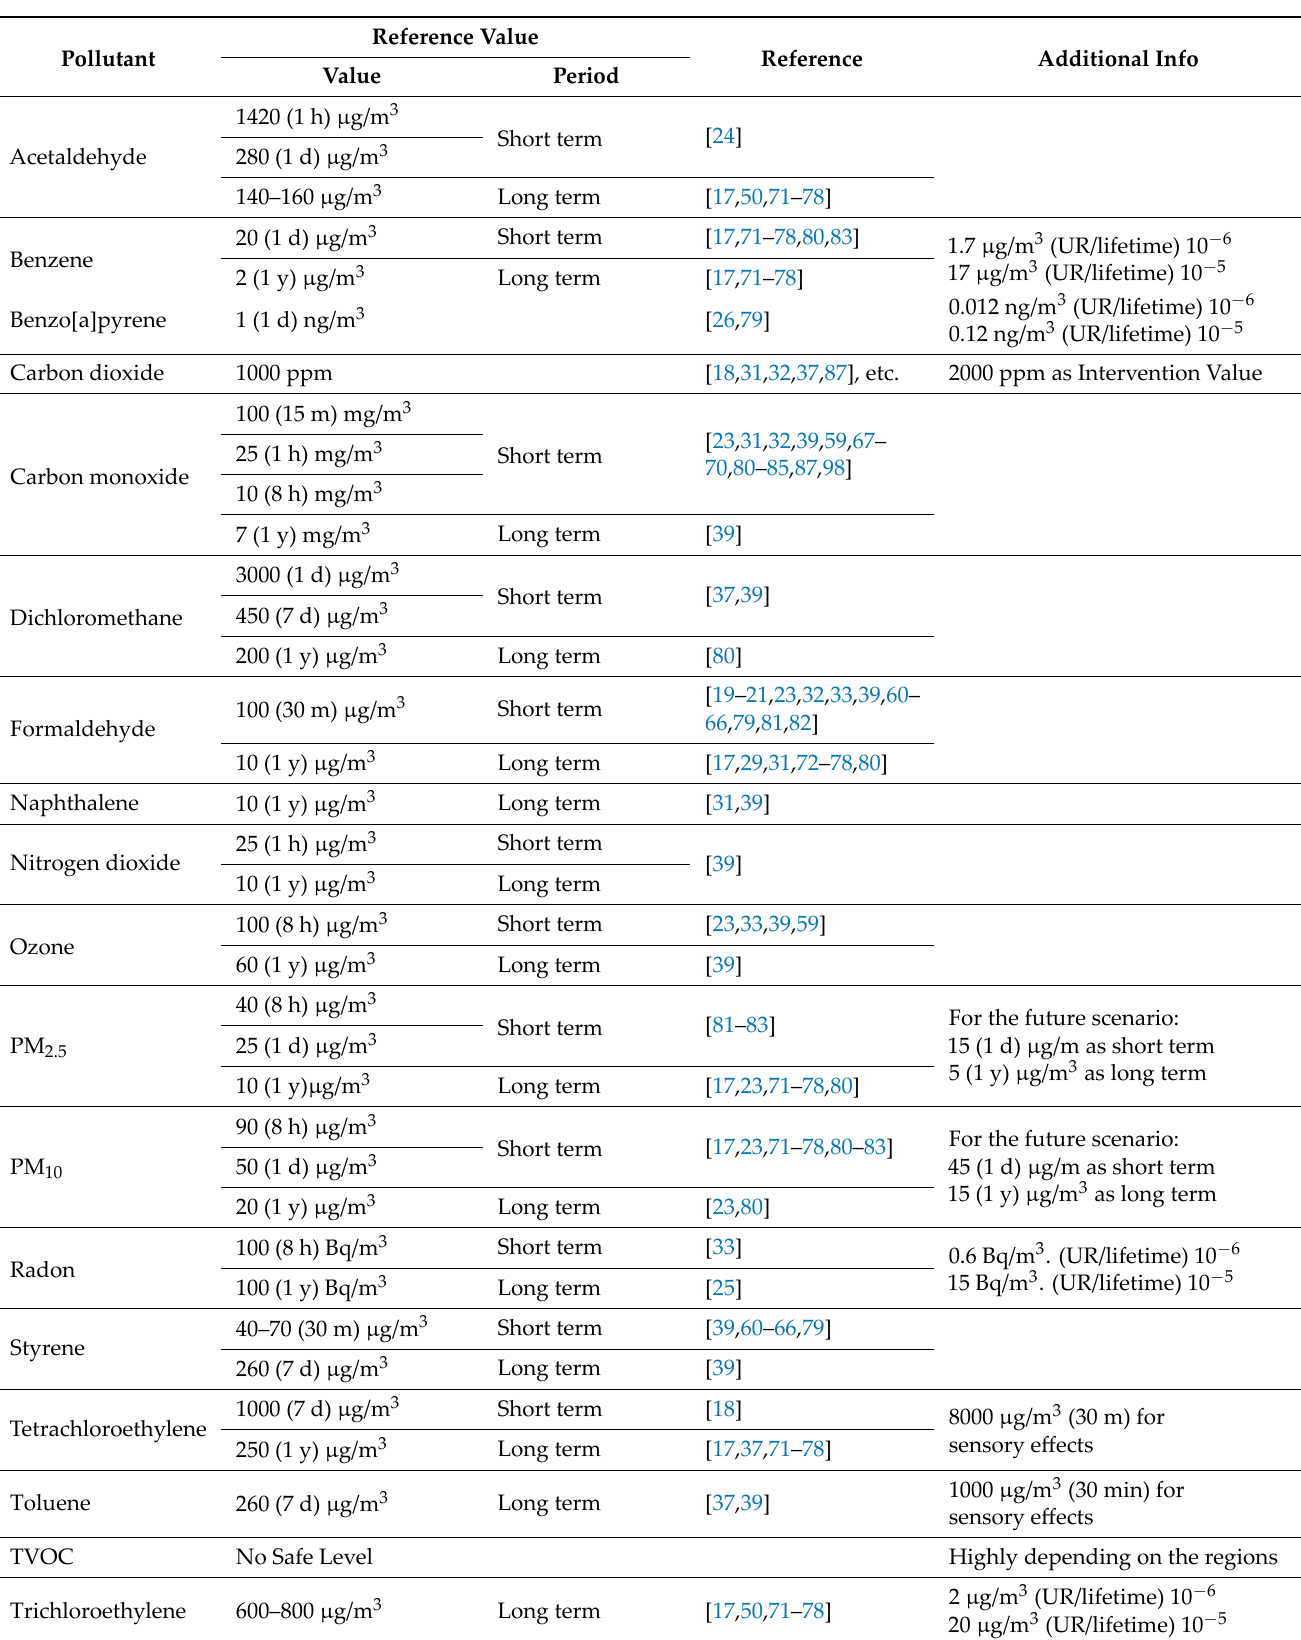
Table 26. Guidelines’ values for chemical compounds for generic